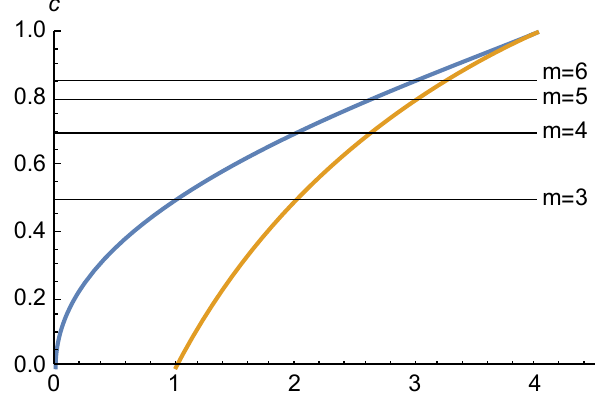
Figure 9: Central charge of the critical (yellow) and tricritical (blue) Potts model as a function of Q . The central charge of several unitary minimal models is indicated by horizontal